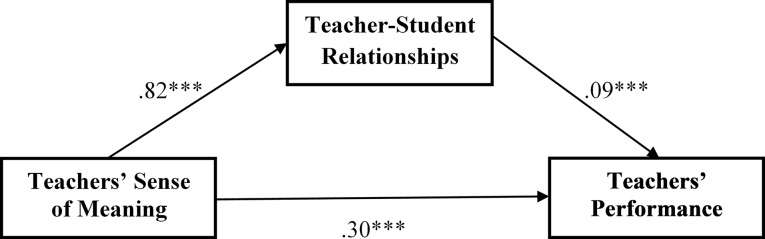
The mediation model.